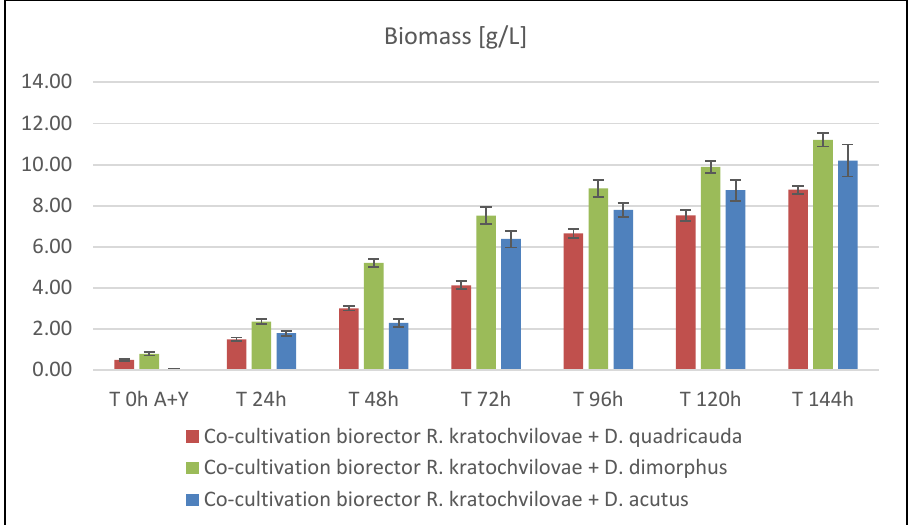
Figure 5. Biomass production in laboratory bioreactor co-culture of R. kratochvilovae and microalgae Desmodesmus strains.